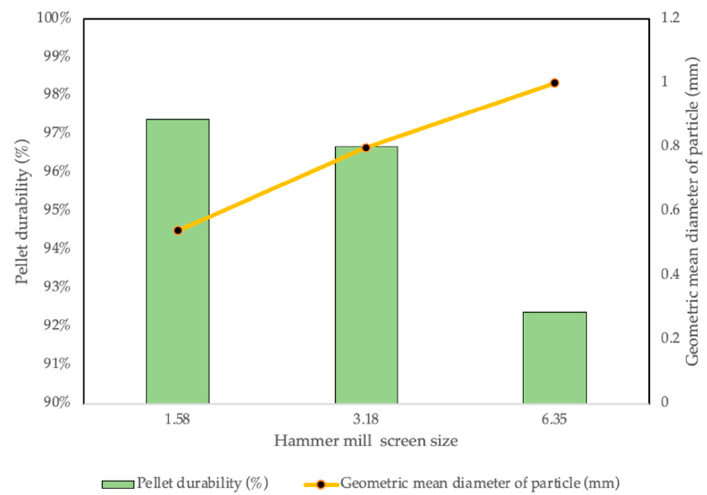
Figure 5. Effect of particle size on wheat-based swine diet pellet durability [58].